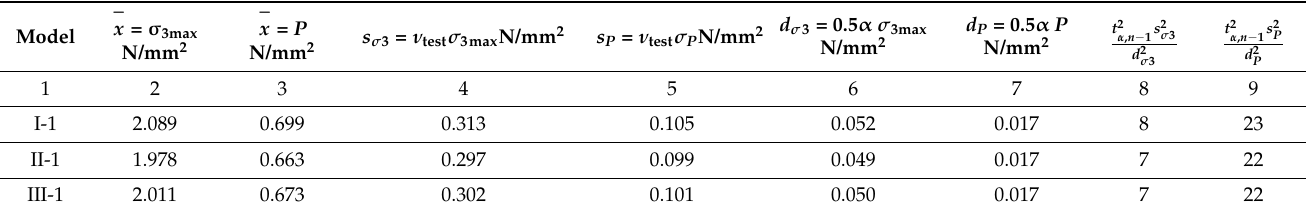
Table 11. Minimum number of measuring points to determine the stresses σ 3 and P